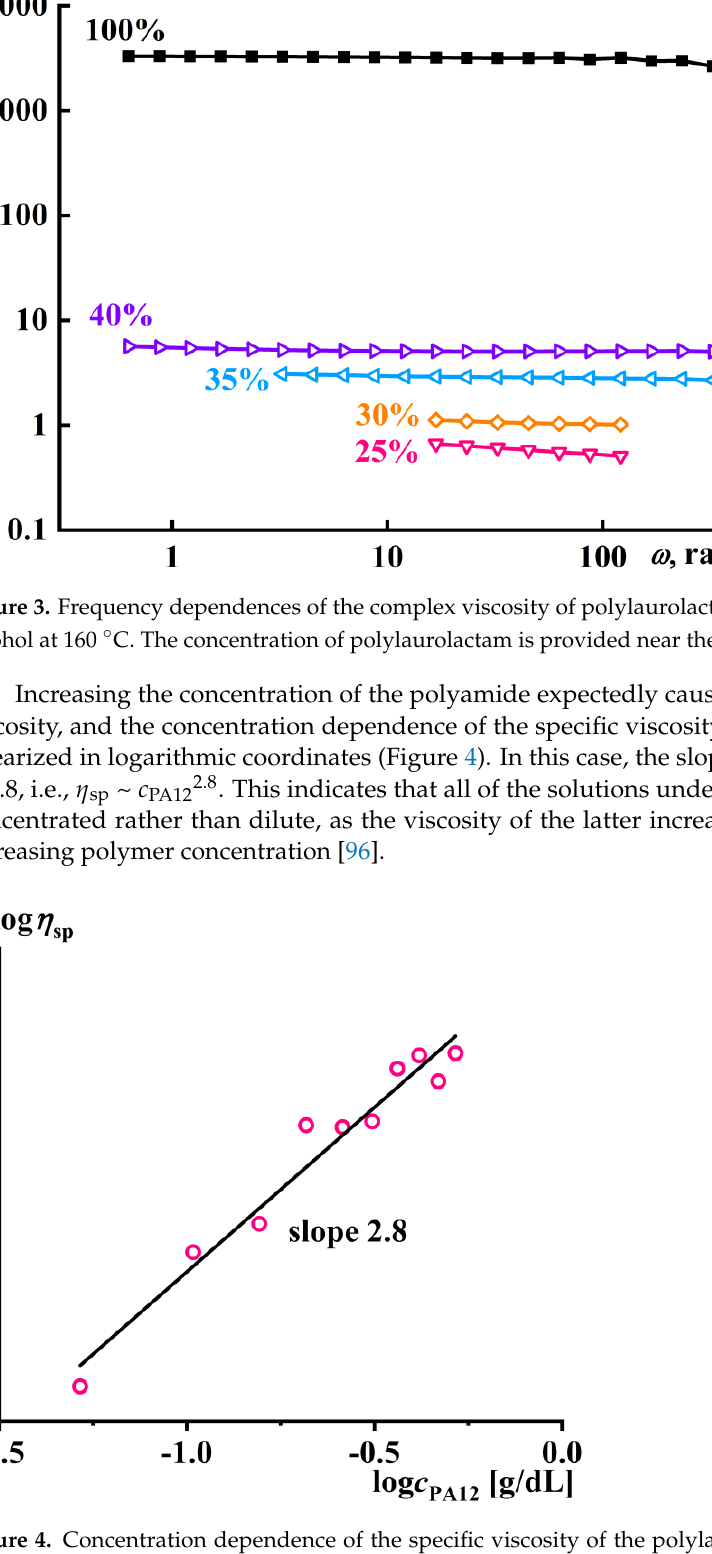
Figure 4. Concentration dependence of the specific viscosity of the polylaurolactam solutions in benzyl alcohol at 160 °C.